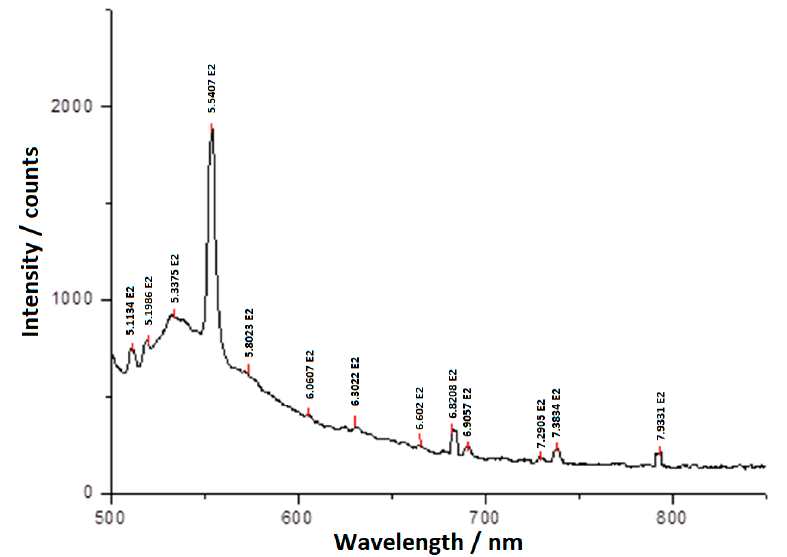
Figure 8. Laser electronic fluorescence spectrum of the BPA solution in acetone, with concentration c = 1%.